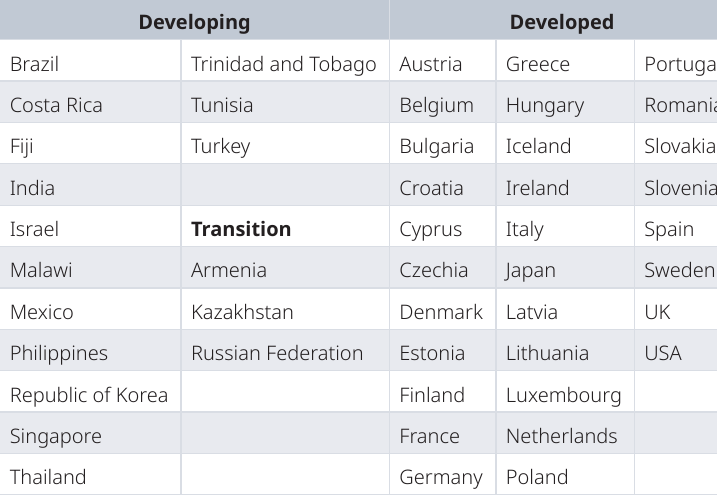
Table 1. List of countries in the study. Developing